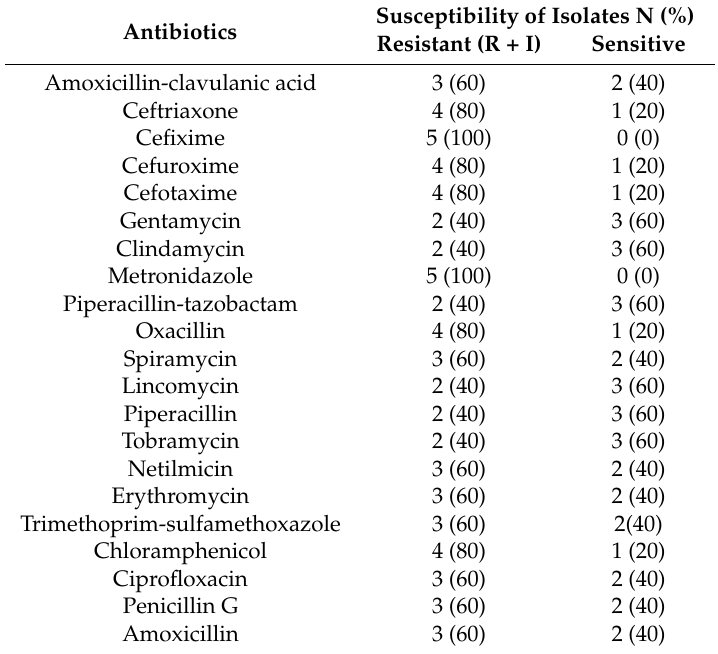
Table 2. Antimicrobial susceptibility of Lactococcus lactis ssp. lactis